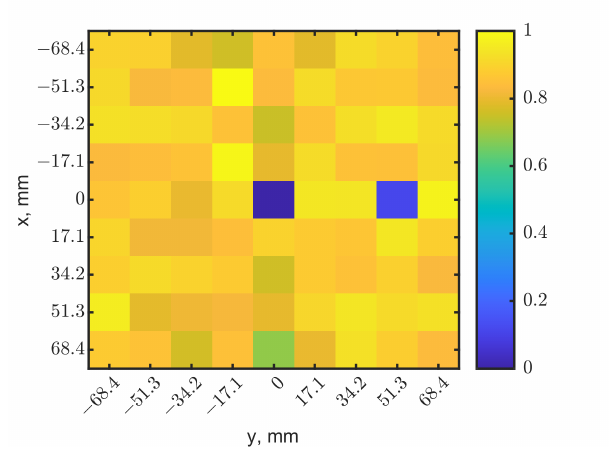
Figure 11. Synthesized heatmap for two tumors at (x = 0, y = 0) and (x = 0, y = 51.3). The dark-blue pixel indicates the tumor’s